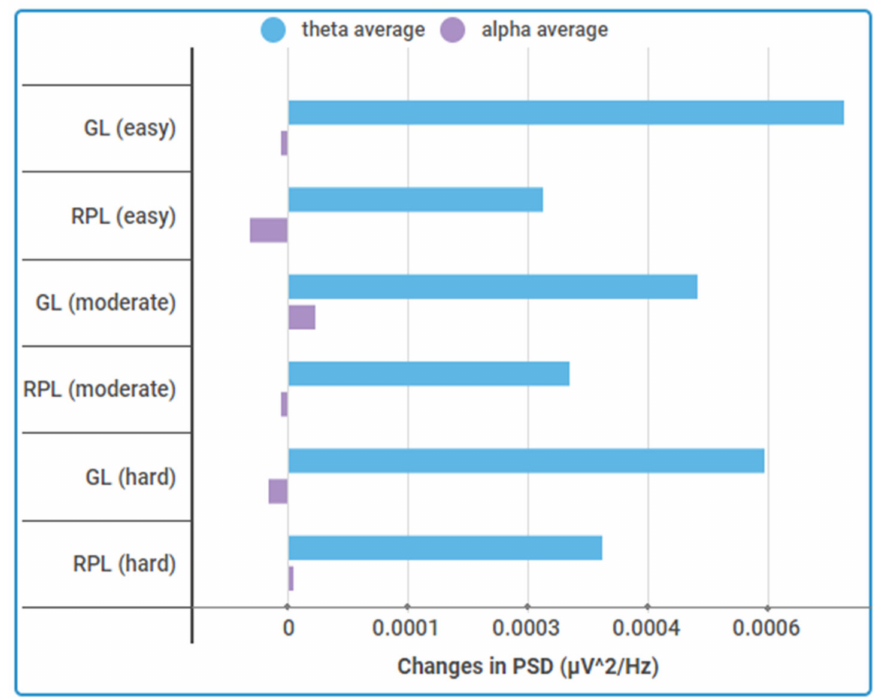
Figure 8. Changes in PSD of alpha and theta power changes for good learners and relatively poor learners ( µ V 2 / Hz) (Alpha values are multiplied by 10 for visualization